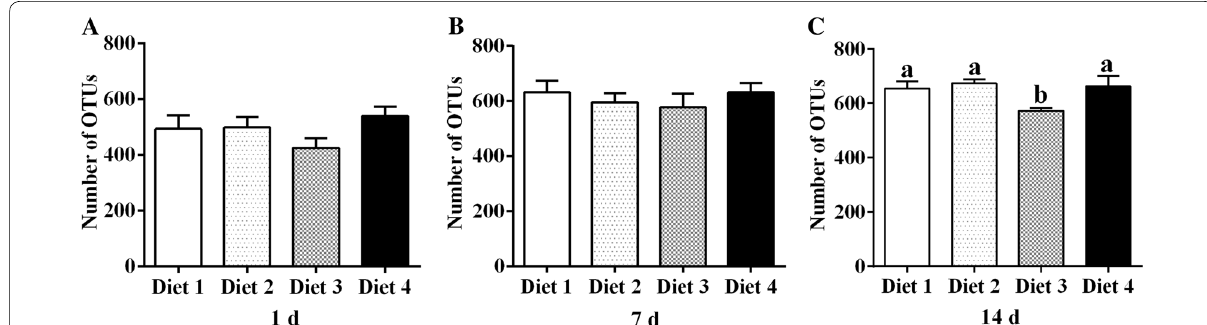
Fig. 1 Comparison of the OTUs of the four groups on different experimental days. The number of observed OTUs in fecal samples collected at experimental day 1 ( A ), day 7 ( B ), and day 14 ( C ) sharing the sequence similarity of 97% is shown. a,b Small letter superscript represents significant ≥ difference ( P < 0.05). Data were statistically analyzed by repeated-measures one-way ANOVA, followed by Duncan’s multiple-range test